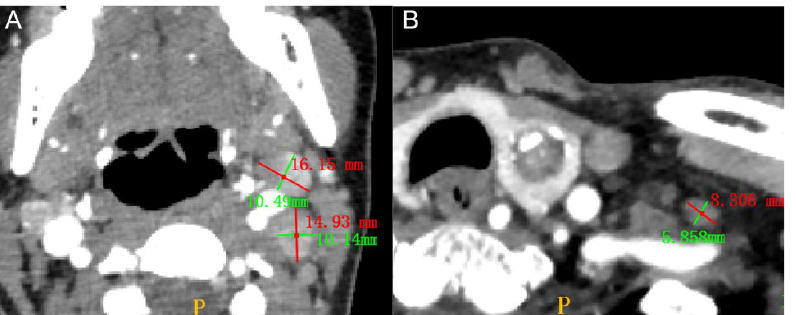
Figure 2. ( A ) Two metastatic lymph nodes, demonstrating substantial but uneven enhancement in the arterial phase, with maximum short-axis diameters of more than 10 mm (maximum long-axis diameters of 16.15 mm and 14.93 mm and maximum short-axis diameters of 10.49 mm and 10.14 mm, respectively). ( B ) A normal, oval and nonmetastatic lymph node, seen to the left of the primary lesion (maximum long-axis diameter of 8.31 mm and maximum short-axis diameter of 5.86